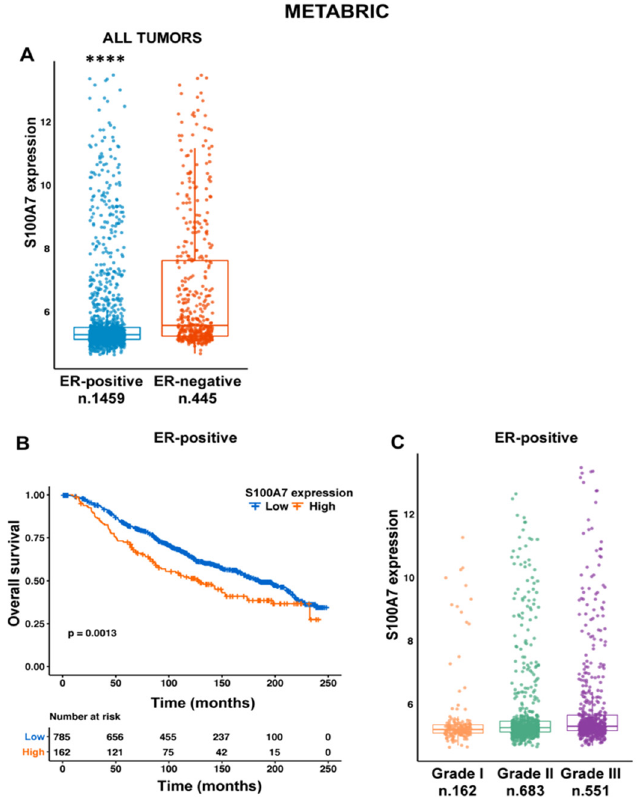
Figure 1. S100A7 correlates with adverse clinico-pathological features in ER-positive breast cancer patients. ( A ) Box plot depicting the differential expression of S100A7 in ER-positive and ER-negative BC patients as found in the METABRIC cohort; (****) p < 0.0001. ( B ) S100A7 expression correlates with a worse overall survival of ER-positive BC patients in the METABRIC cohort. ( C ) The expression levels of S100A7 were higher in ER-positive BC patients with more advanced tumor grade. (****) p < 0.0001; the number of patients of each group is indicated in the figure.